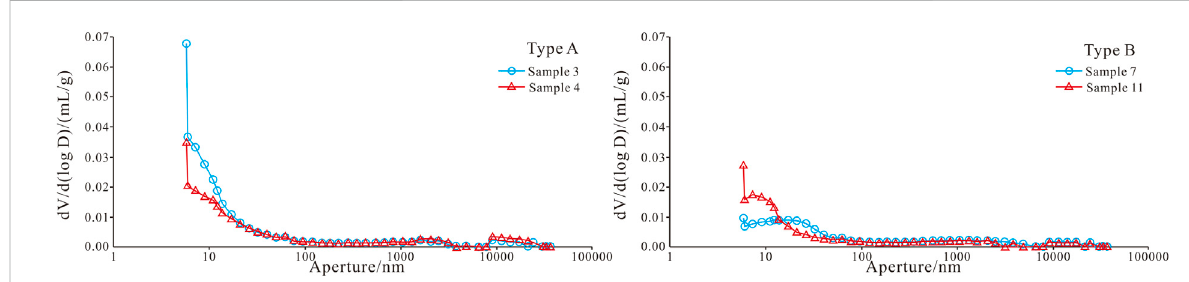
FIGURE 4 Aperture distribution curve based on the high-pressure mercury injection experiments.